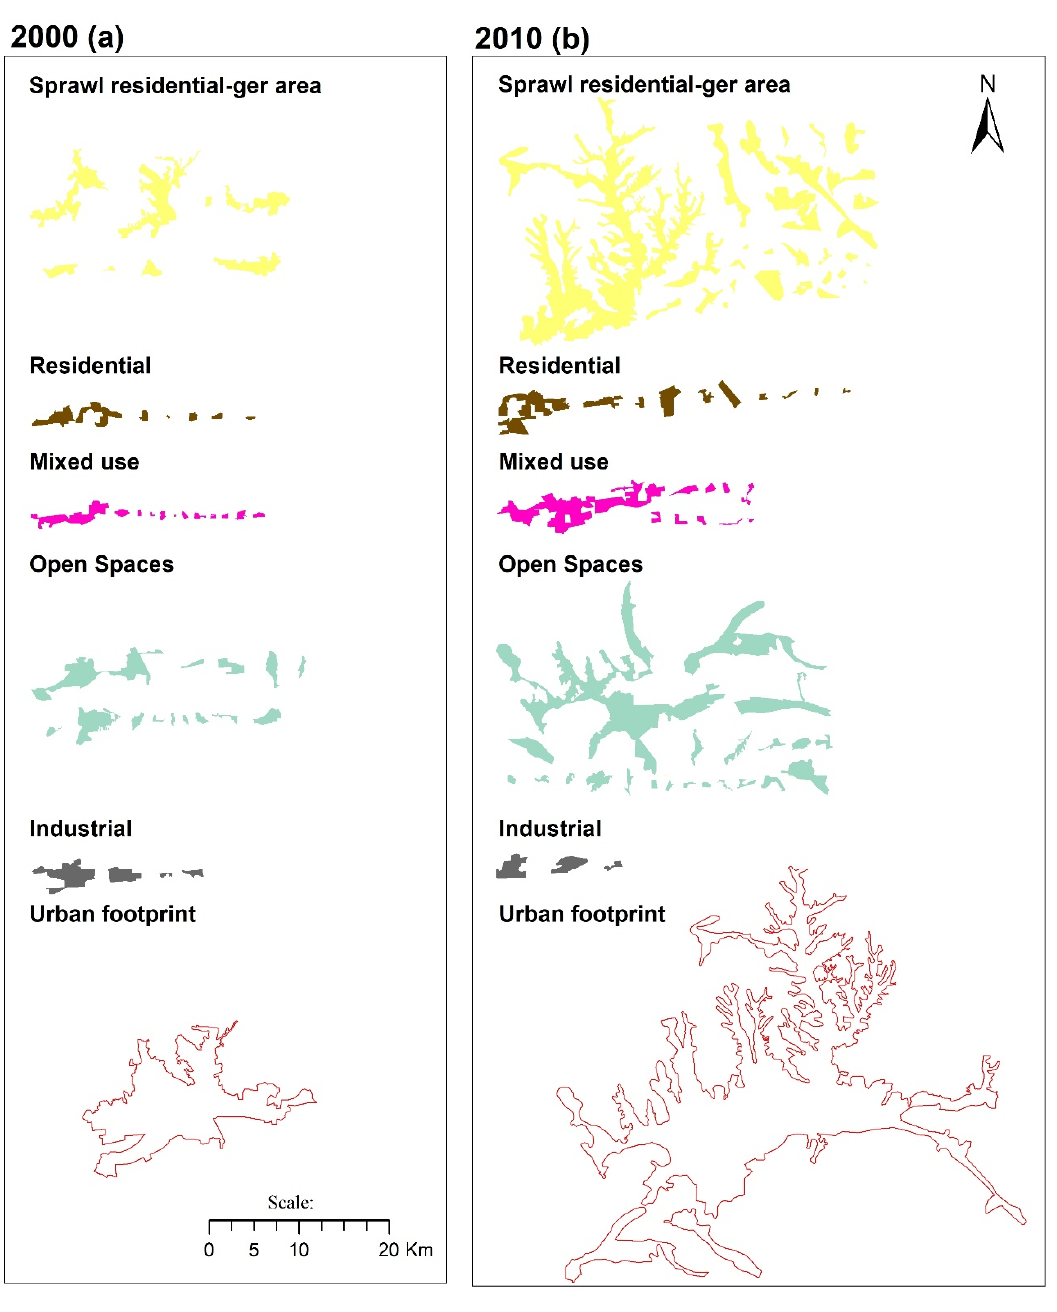
Figure 3. Parcels separated into individual land-use classes, Ulaanbaatar in ( a ) 2000 and ( b ) 2010.